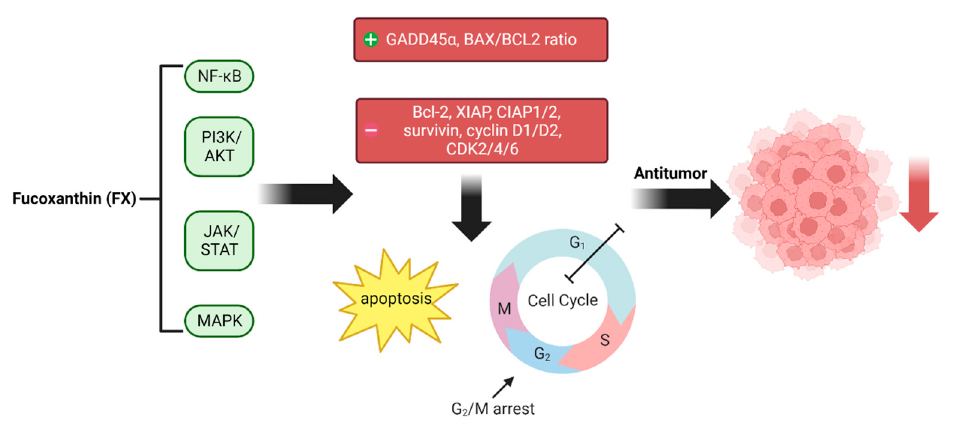
Figure 4. Pathway underlying the anti-tumor and anti-cancer effects of fucoxanthin (FX). FX achieves its anti-tumor effects by inhibiting inflammatory pathways such as NF- κ B, MAPK, JAK-STAT, and PI3K/AKT. The expression level of GADD45 α and the BAX/BCL2 ratio increased, and the expression of related cell cycle proteins, such as CDK2/4/6, Bcl-2, XIAP, and CIAP1/2, decreased after the related inflammatory pathways were inhibited by FX, which led to the regulation of apoptosis and cell cycle arrest, thus controlling tumor and cancer development and